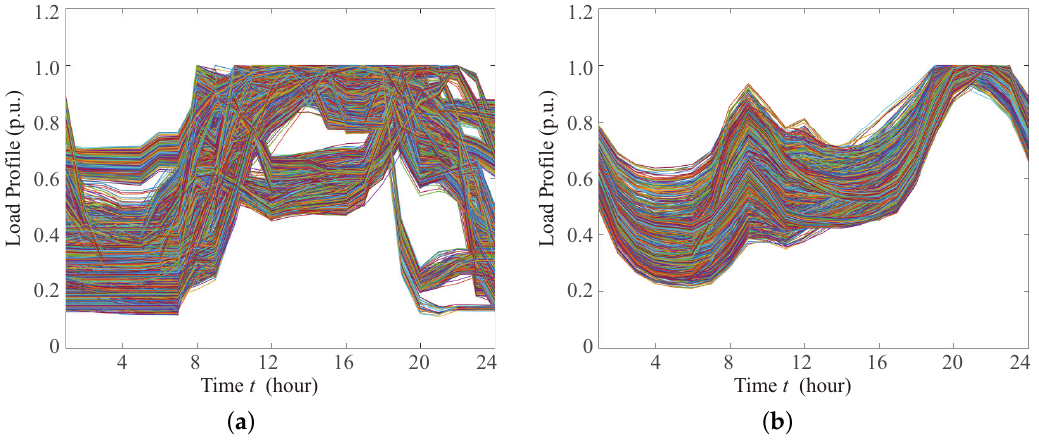
Figure 11. Real load profiles in the commercial and residential areas: ( a ) commercial area, and ( b ) residential